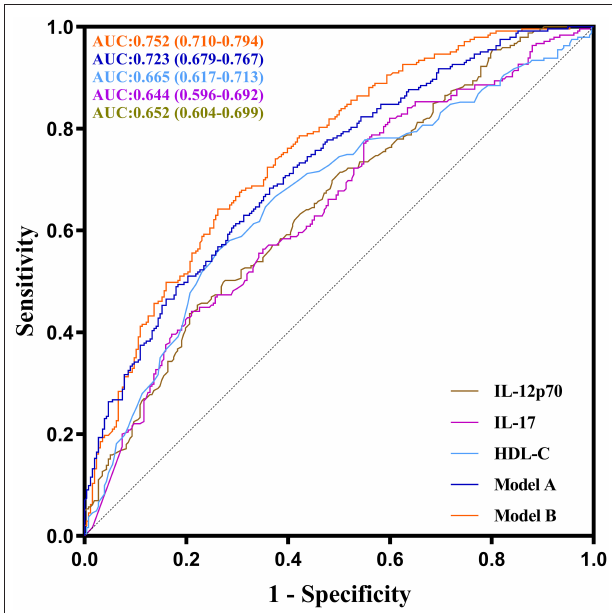
FIGURE 4 | ROC curves of IL-12p70, IL-17, HDL-C and their combination showing different abilities to predict severe CAD. The AUC of the serum IL-12p70 level was 0.652 (95 %CI: 0.604–0.699, P < 0.001), the AUC of the serum IL-17 level was 0.644 (95 %CI: 0.596–0.692, P < 0.001), the AUC of the HDL-C level was 0.665 (95 %CI: 0.617–0.713, P < 0.001), the AUC of the model A(combined IL-12p70, IL-17 and HDL-C) was 0.723 (95 %CI: 0.679–0.767, P < 0.001), and the AUC of the model B (combined IL-12p70, IL-17, HDL-C, gender and diabetes) was 0.752 (95 %CI: 0.710–0.794, P <